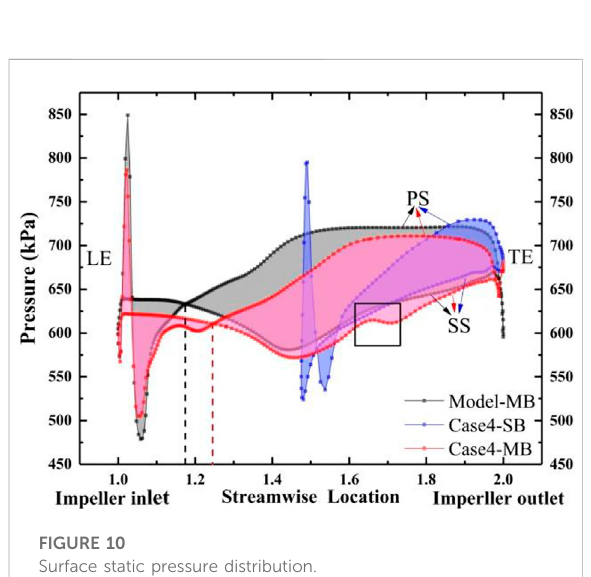
FIGURE 10 Surface static pressure